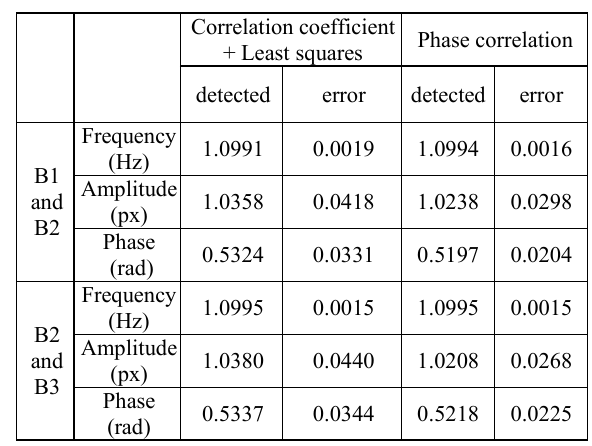
Table 2 . Obtained parameters of jitter curve